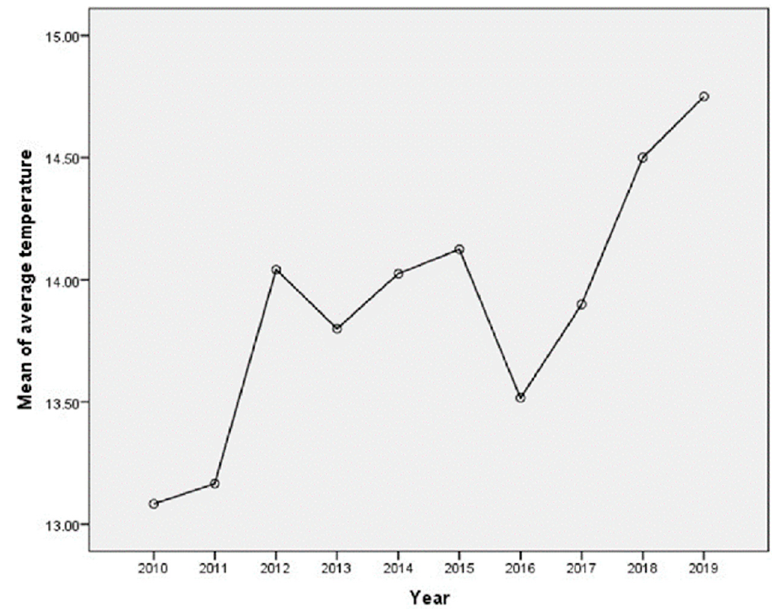
Figure 2. Mean temperatures per year in Belgrade, Serbia between the years 2010 and 2019. Rates of stillbirths were similar in spring and summer compared to autumn and winter months (233 vs. 186; p = 0.317) as well as if temperatures were <15 ◦ C and ≥ 15 ◦ C (200